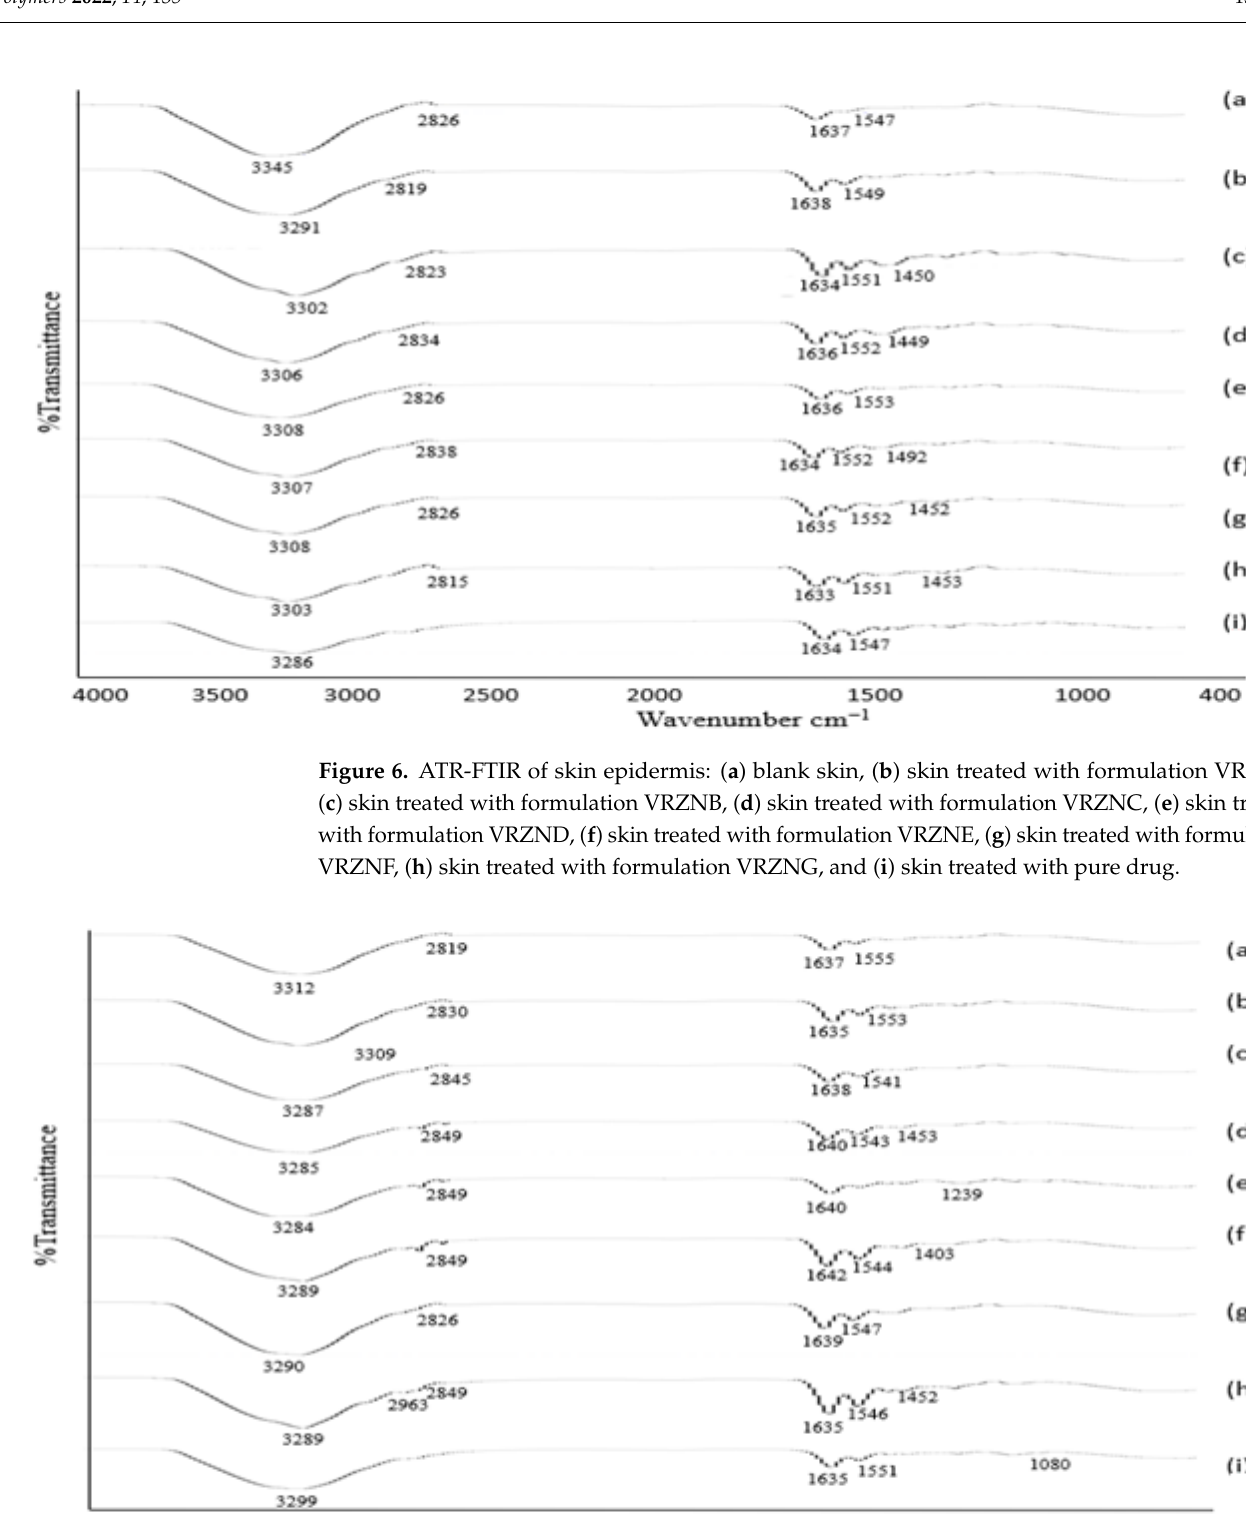
Figure 7. ATR-FTIR of skin dermis: (a) blank skin, (b) skin treated with formulation VRZNA, (c) skin treated with formu- lation VRZNB, (d) skin treated with formulation VRZNC, (e) skin treated with formulation VRZND, (f) skin treated with formulation VRZNE, (g) skin treated with formulation VRZNF, (h) skin treated with formulation VRZNG, and (i) skin treated with pure drug.